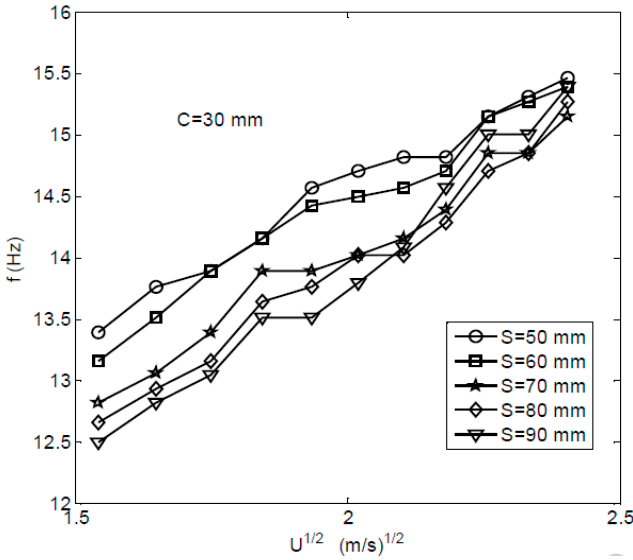
Figure 4. Oscillation frequency as function of wind velocity.